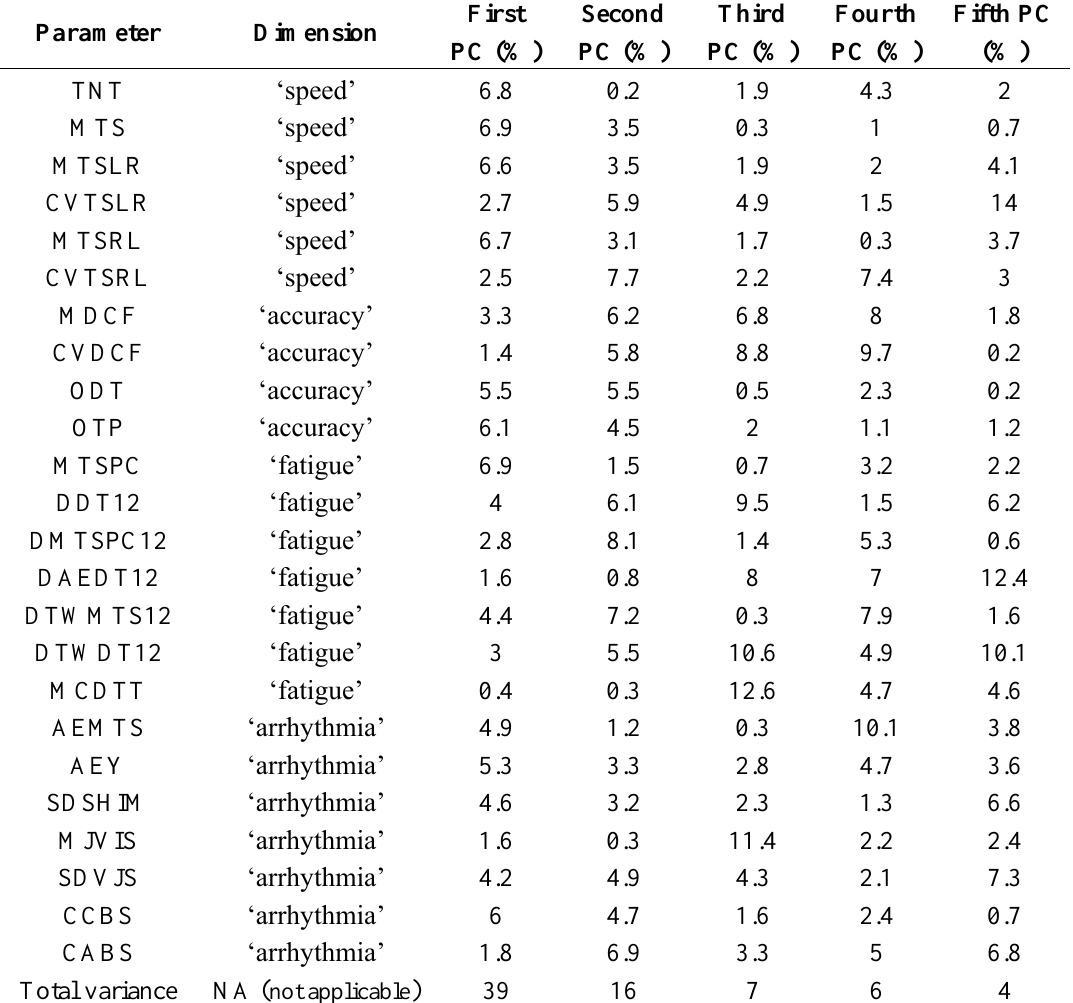
Table 2. Percentage total variance accounted for by first 5 PCs and contributions of the 24 parameters in each one of them. Details of the parameters are discussed in the